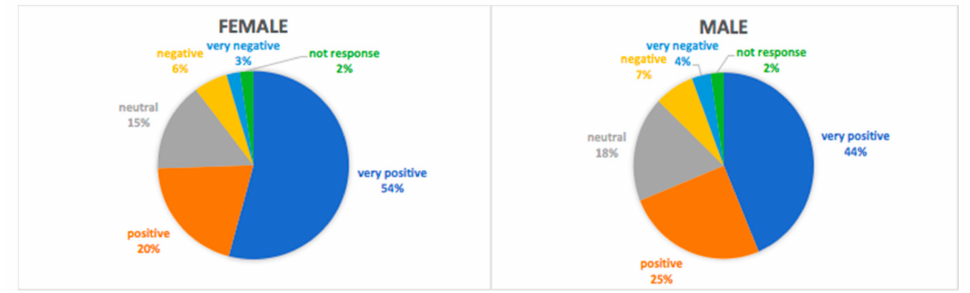
Figure 7. Results of the attention dimension by gender.